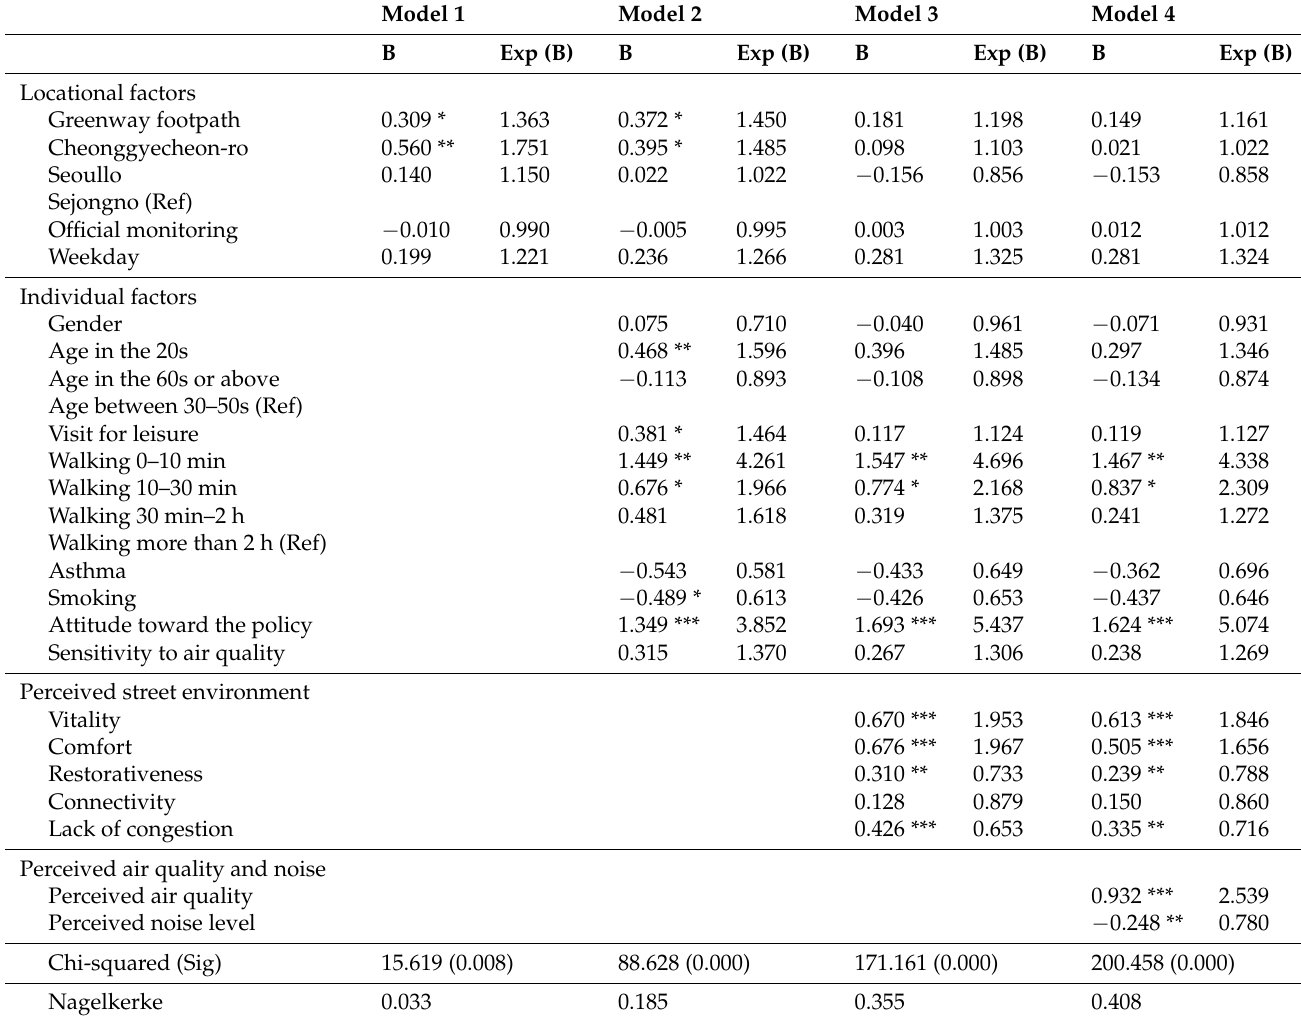
Table 6. Results of binary logistic model of street